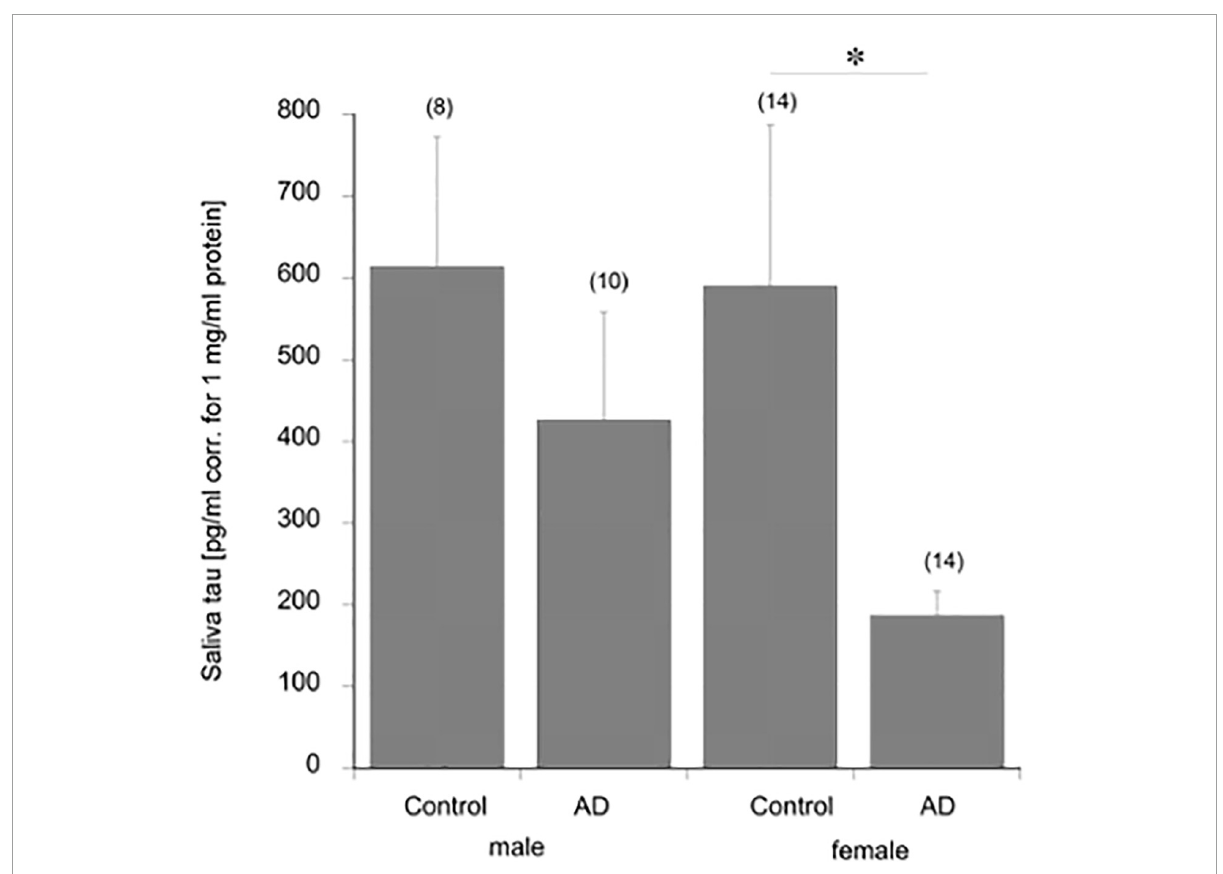
FIGURE3 Total tau saliva levels in male and female controls and patients with Alzheimer’s disease dementia (AD). Saliva was collected, analyzed for total tau by Lumipulse, and corrected for the protein. Values are given as mean ± SEM and the values in parenthesis give the number of analyzed patients. Statistical analysis was performed by one-way ANOVA with a subsequent Fisher LSD post-hoc test ( ∗ p ≤